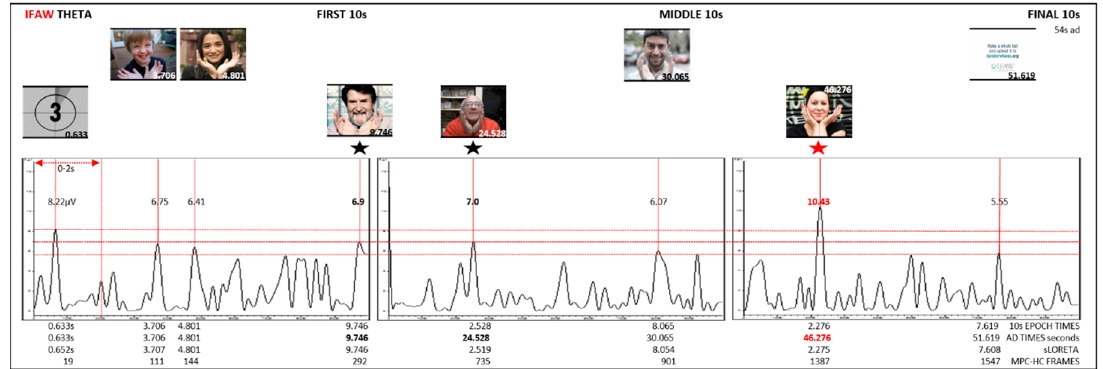
Figure 2. ManUp grand average theta from first, middle, and final 10second epochs.